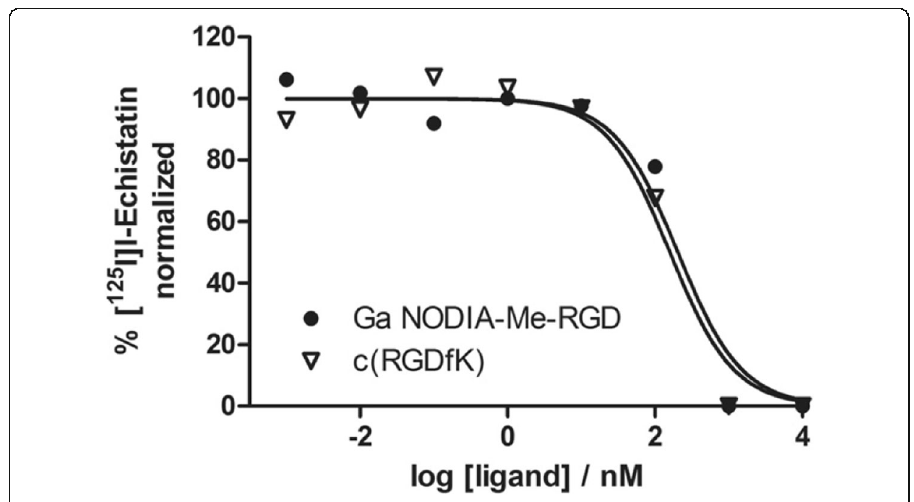
Fig. 1 Inhibition of [ 125 I]I-echistatin binding to integrin α v ß 3 on U-87 MG cells by c(RGDfK) 2 (IC 50 = 159.5 ± 1.3 nM) and nat Ga-NODIA-Me-c(RGDfK) [ nat Ga] 3 (IC 50 = 205.1 ± 1.4 nM) ( n = 2 in triplicate, mean ±